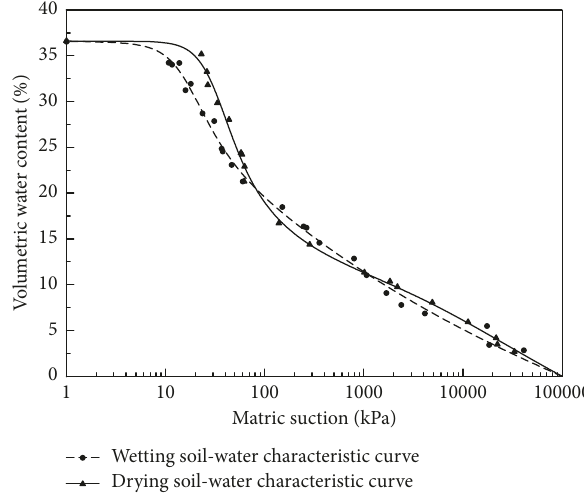
Figure 12: Loess compacted at optimum.